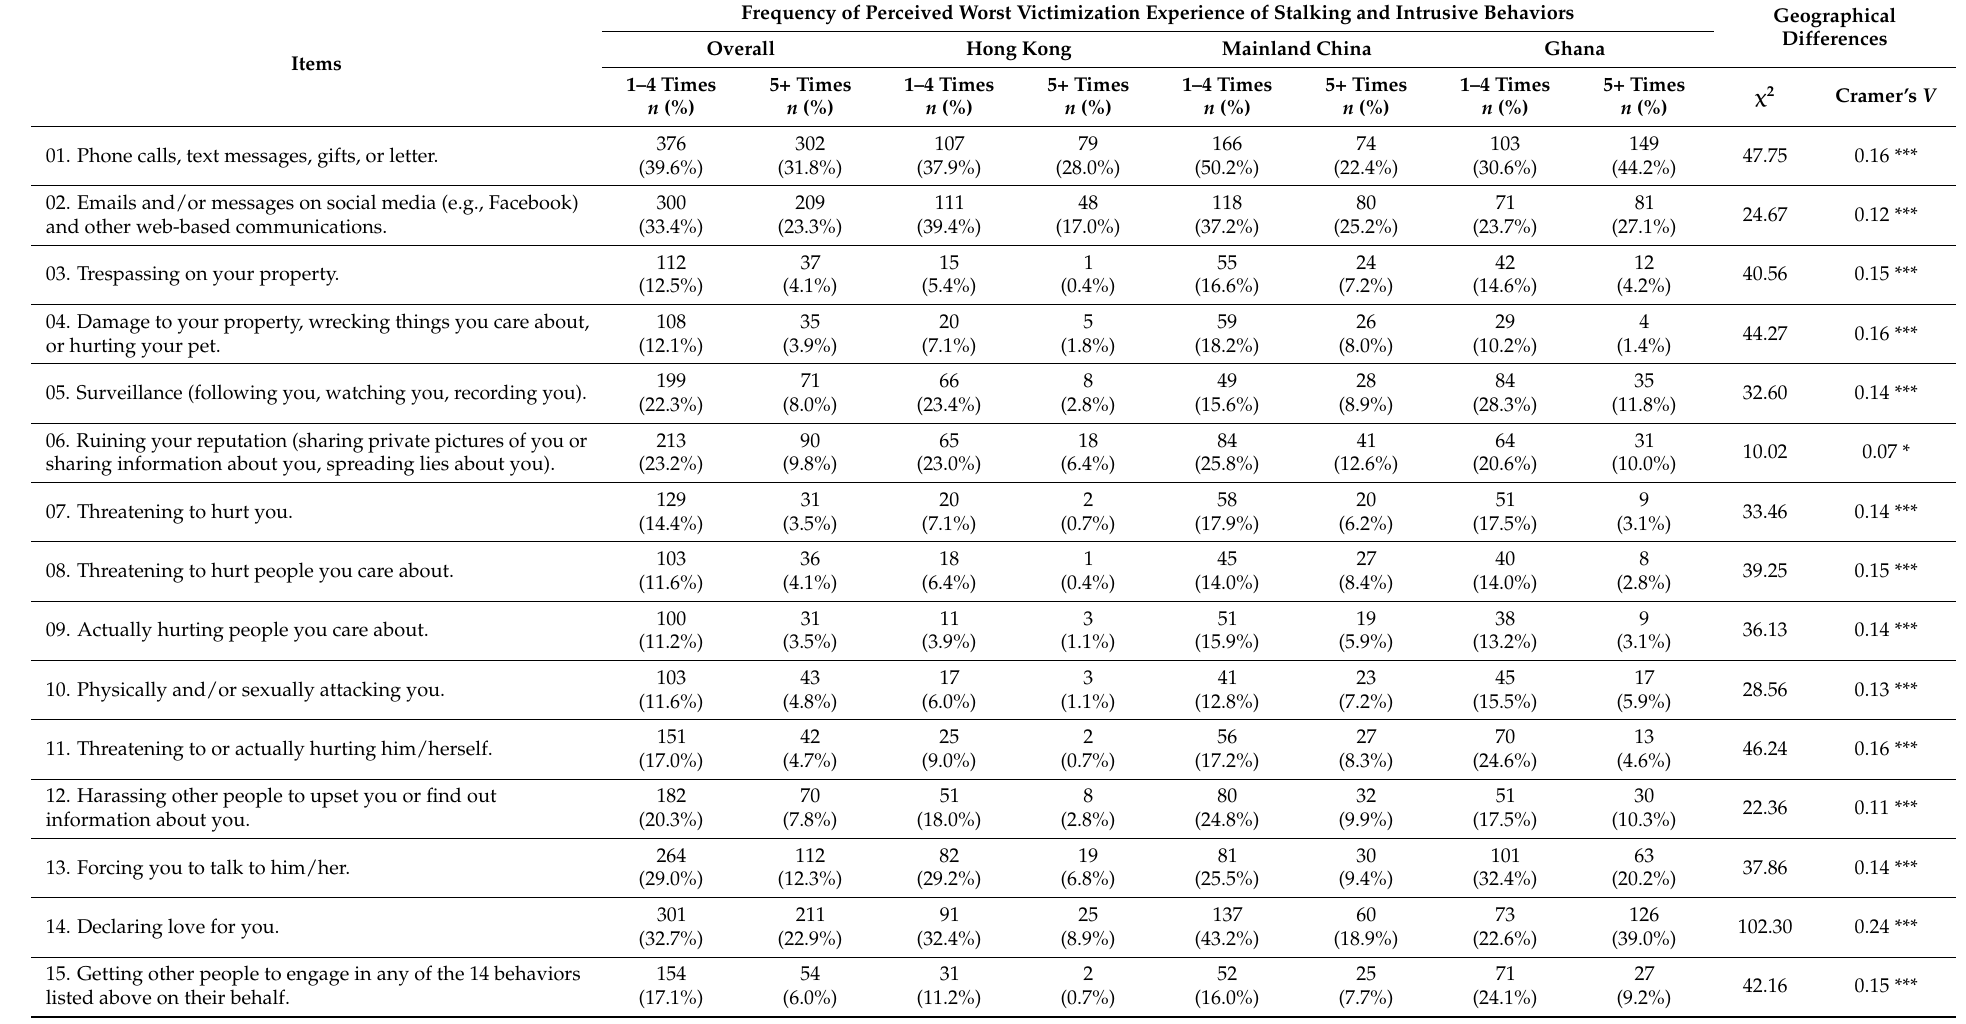
Table 3. Geographical distribution of perceived worst experiences of stalking and intrusive behavior victimization frequency ( n = 1143).